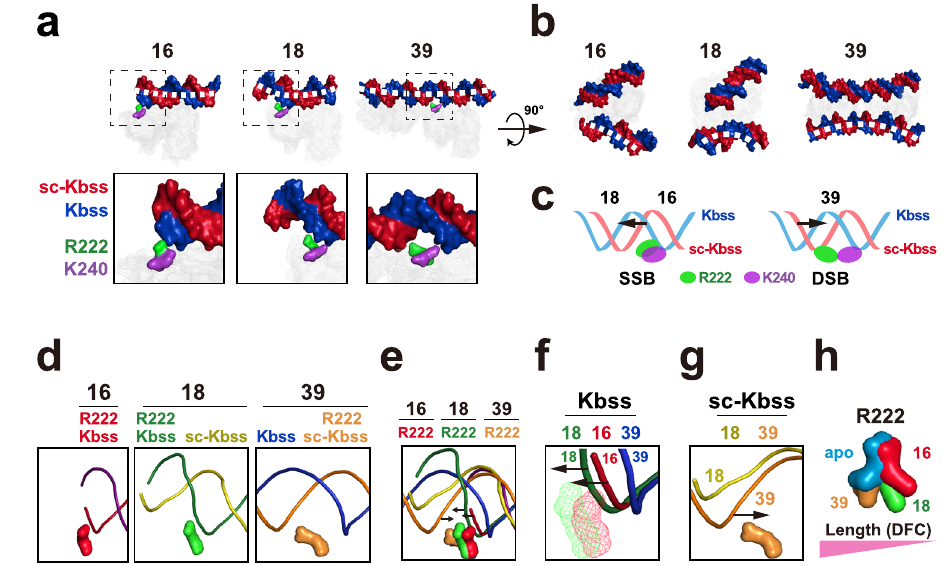
Fig. 7 | R222 might curve DNA to sense fl exibility. a Surface structures showing thatR222(green)and K240(purple)mightbindthesameDNAsinglestrand(Kbss) in16and18atomicmodels,whileR222andK240mightseparatelybindthedistinct single strands (Kbss and sc – Kbss) in 39 atomic model. The DNA Kbss and sc – Kbss are shownbythe red and blue surface models, respectively. The cGAS proteins are shown by mesh representations. Blue and Red: DNA; Green: R222; Purple: K240. b Surface structures showing that the DNAsare curvedto different direction in 16, 18and39atomicmodels.TheDNAKbssandsc – Kbssareshownbytheredandblue surface models, respectively. The cGAS proteins are shown by mesh representa- tions. Blue and Red: DNA. c Schematic showing that the distinct-strand-binding (DSB) and same-strand-binding (SSB) models might curve the sc-Kbss (red) and Kbss (blue) single strands, respectively. Blue and pink: DNA; Green: R222; Purple: K240. d , e Superposition showing that the DNA conformational changes might be